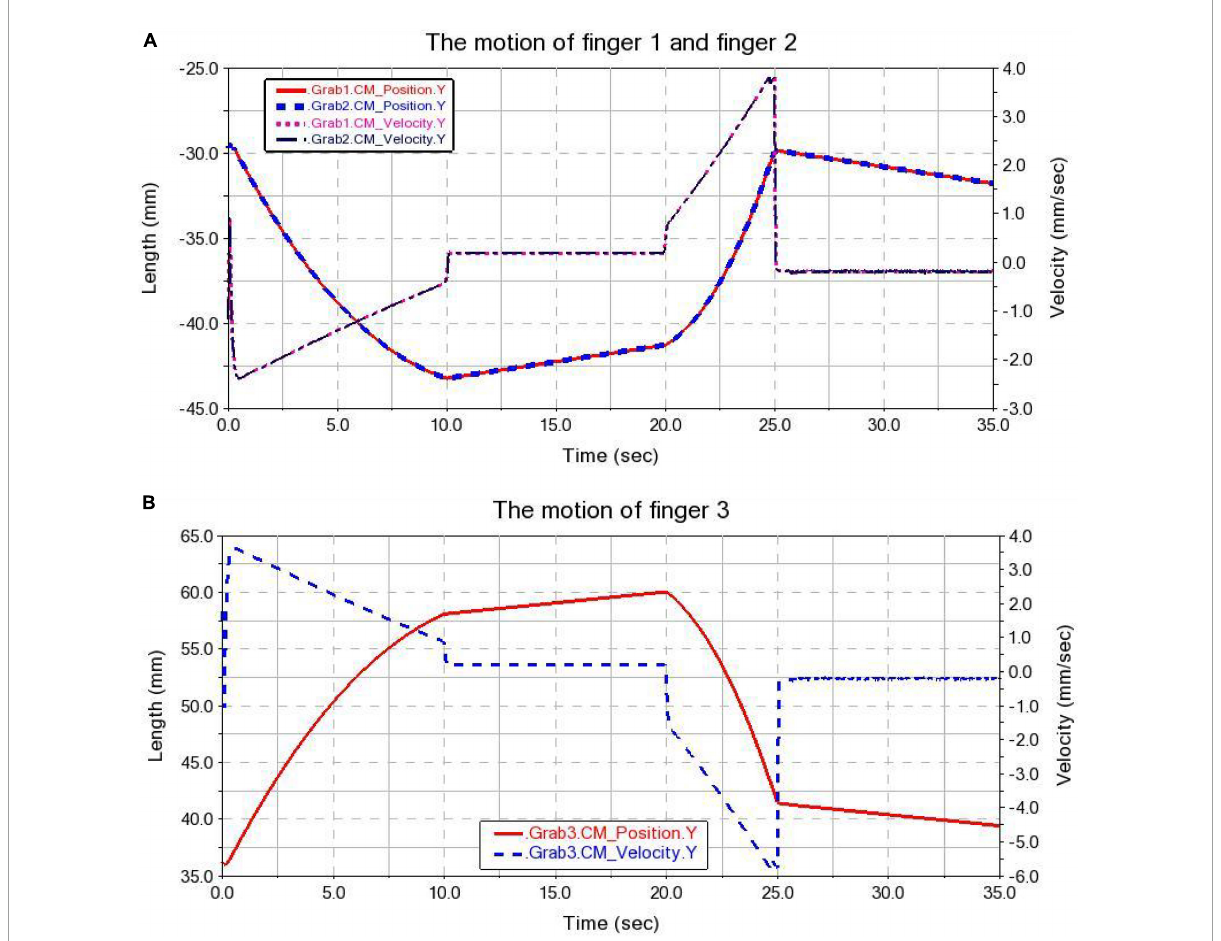
FIGURE13 Finger movement (A) the motion of finger 1 and finger 2; (B) the motion of finger 3. (2) Slider motion state.